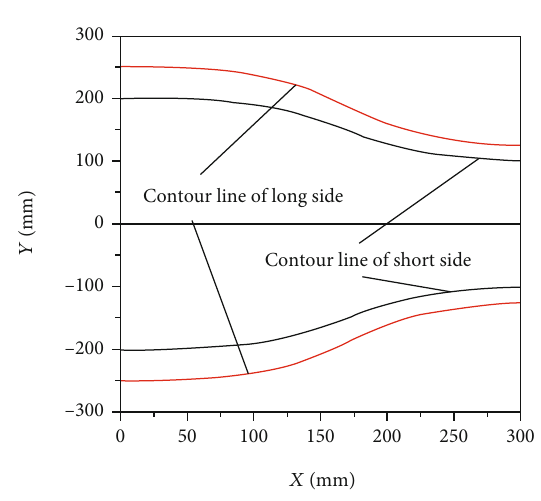
Figure 2: Curve of the contraction section.